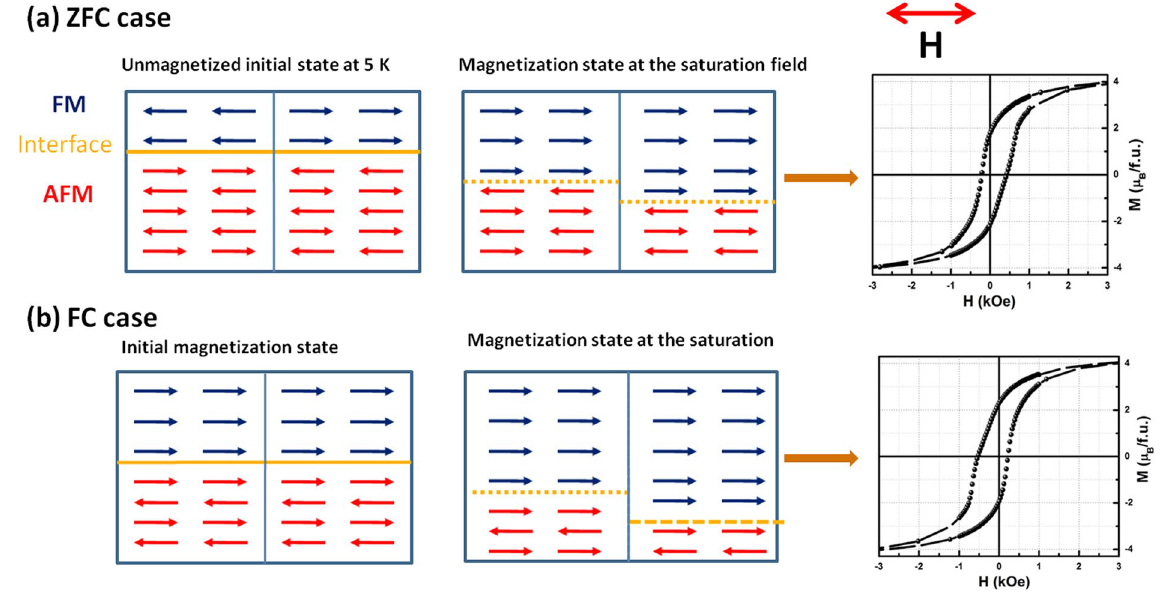
Figure 6. Schematic representation of the spin configuration at different stages (left): for the ZFC (a) , and FC cases (b) . Here note that the spin configuration is a simple cartoon to illustrate the interface coupling. The resultant hysteresis loop of SEB and CEB effects